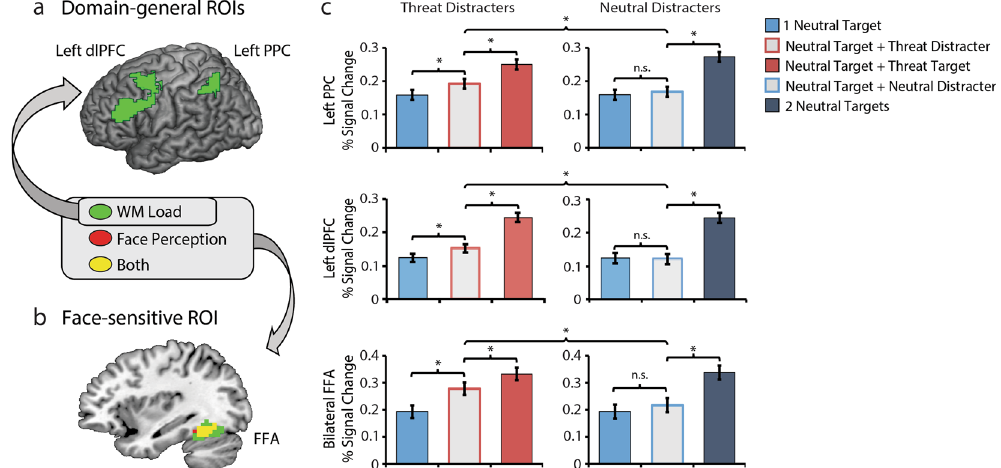
Figure 2. WM is mis-allocated to threat-related distracters. To enhance reproducibility and power 16 , hypothesis testing focused on several key WM regions. Each ROI was defined using a combination of anatomical and functional criteria. ( a ) Domain-general ROIs . WM load-sensitive voxels within the dlPFC (MFG) and PPC (IPL) are depicted in green ( p s < 0.05, corrected). ( b ) Face-sensitive ROI . Voxels sensitive to both WM load (green) and face perception (red; indexed using data from the independent ‘localizer’ task) within the FFA (temporal- occipital fusiform cortex) are depicted in yellow ( p < 0.05, corrected). (c) Percentage signal change for each condition. As shown on the left side of panel c, activation in the left PPC (top row), left dlPFC (middle row), and bilateral FFA (bottom row) exhibited a monotonic, step-like pattern of activation across conditions, indicating partial mis-allocation of WM resources to the threat-related distracter. As shown on the right side of panel c, the presence of an emotionally neutral distracter was not sufficient to significantly alter activation. Asterisks indicate p < 0.05. Error bars indicate the nominal probability of the null hypothesis being rejected by chance: p < 0.05 (non-overlapping bars) or p > 0.05 (overlapping bars) and were computed as described in ref. 73. Abbreviations—Dorsolateral Prefrontal Cortex (dlPFC), Fusiform Face Area (FFA), Inferior Parietal Lobule (IPL), Middle Frontal Gyrus (MFG), Posterior Parietal Cortex